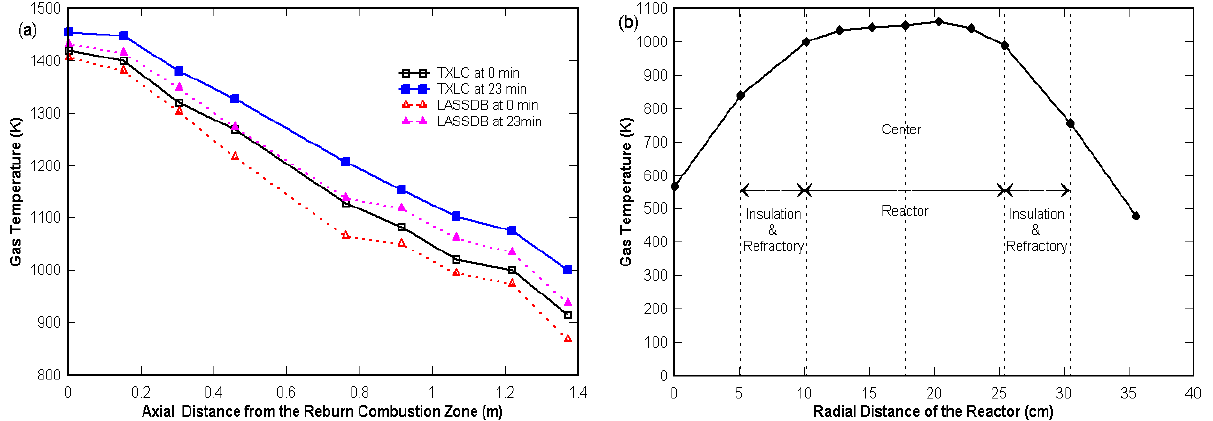
Figure 5. ( a ) Temperature distribution of the flue gas in the reactor over axial distance and ( b ) Temperature distribution of the flue gas in the reactor over radial distance.